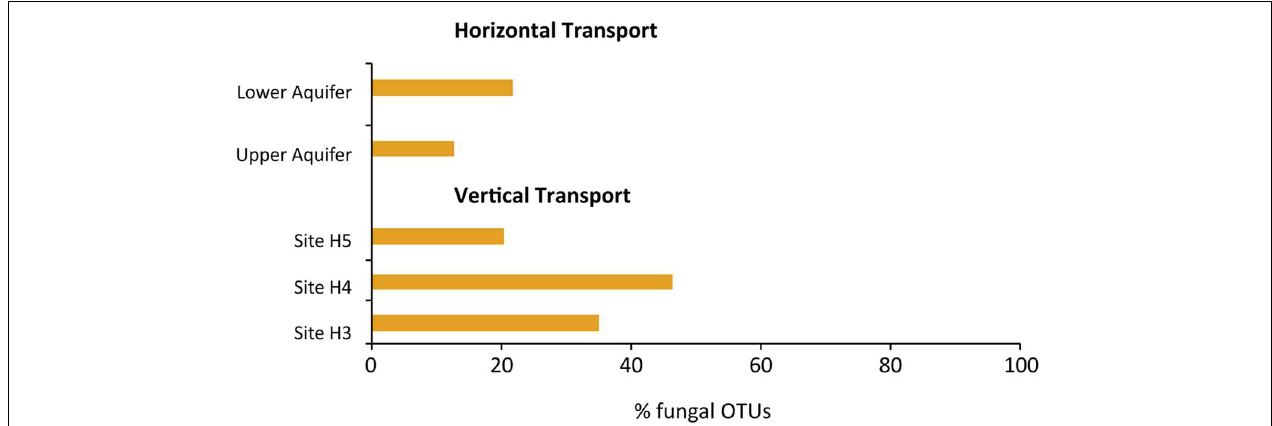
FIGURE 5 | Potential horizontal and vertical transport of fungi within and between the aquifers, estimated on the basis of number of fungal OTUs present in the first sampling site and the number of those fungal OTUs in last sampling site. For horizontal transport, sites H32 and H53 in the upper aquifer and sites H31 and H51 in the lower aquifer were used as the first and last sites. Whereas, for vertical transport, sites H31 and H32, H43, and H41, H53, and H51 were taken as first and last sites for sites H3, H4, and H5,